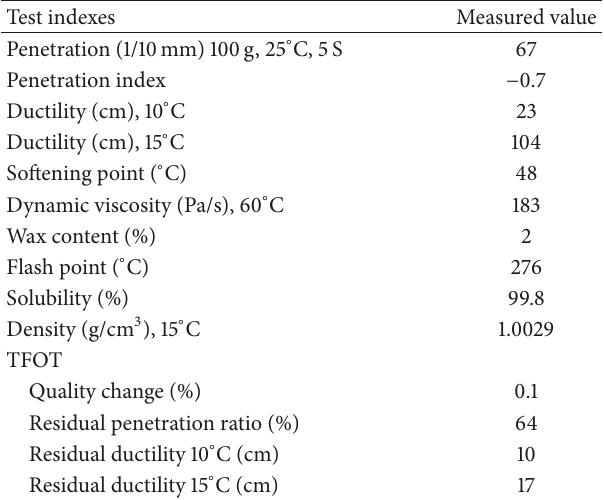
Table 1: Properties of Zhonghai A-70